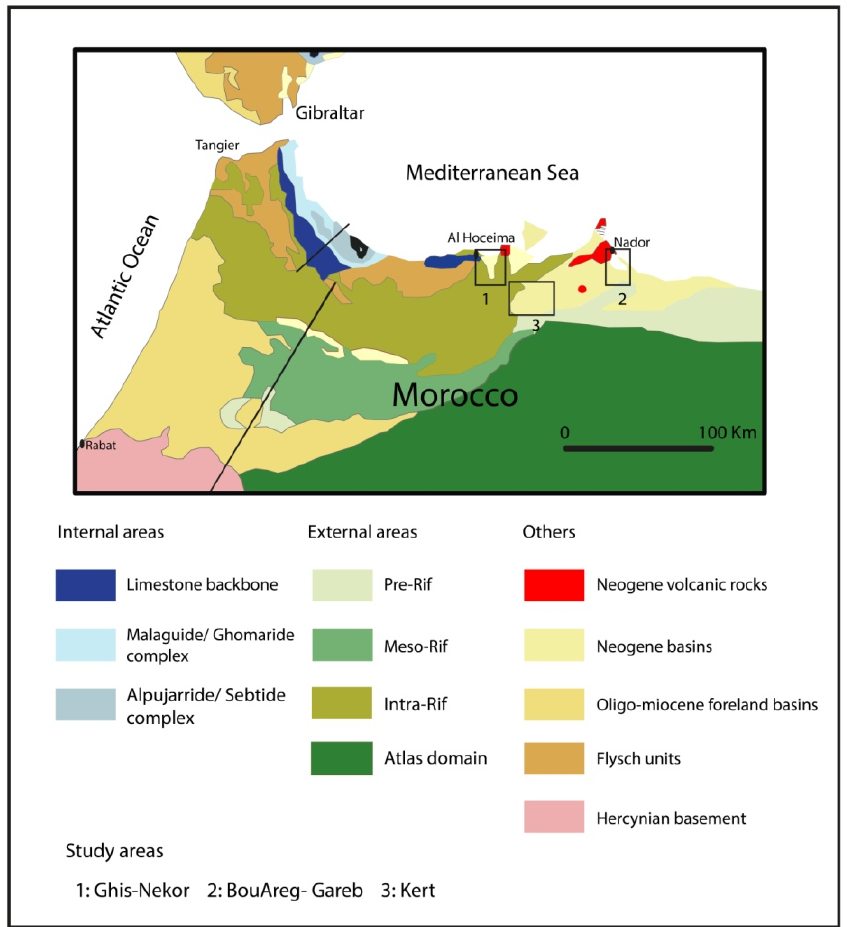
Figure 1. Geological map of Rif ranges and Neogene basins [ 24 ] .